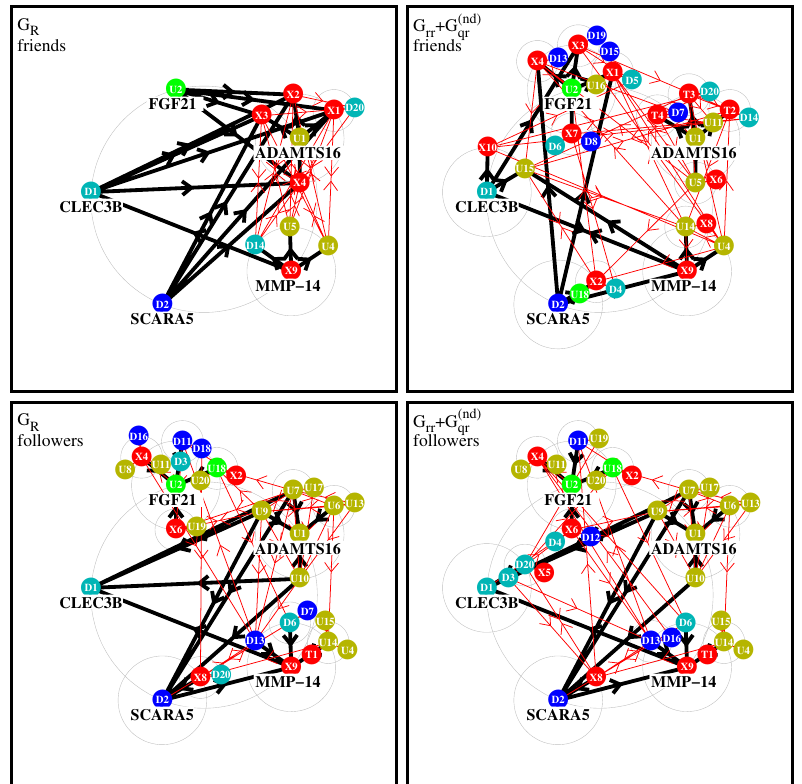
( nd ) qr . Starting from